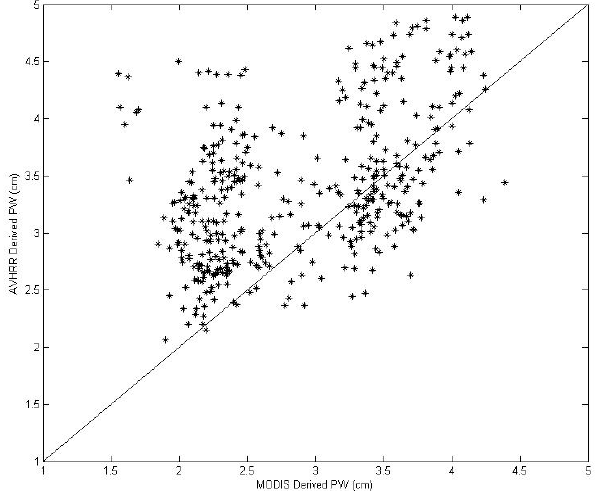
Fig. 5. Scatterplot of MODIS derived PW versus AVHRR derived PW values calculated using the relationship formulated for the broader area of Greece (Chrysoulakis et al., 2008). Finally, in Fig. 6 the spatial distribution of AVHRR derived PW is shown. Mean PW values were estimated by averaging the daily PW values for the whole month (July 2006), for cloud free cells. The effect of topography is obvious. Lower PW values noted at Tilliria, Marathasa and Troodos mountains, (mean PW min =1.61 cm), while higher PW values can be observed in north-eastern area of the island (mean PW max =3.07 cm).